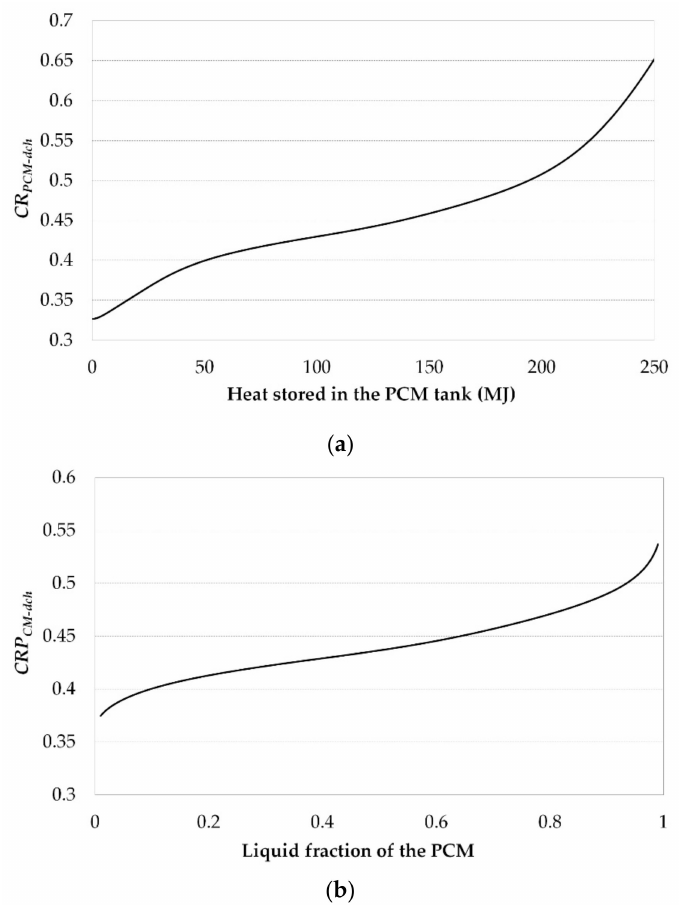
Figure 9. Value of CR in the PCM discharge mode against ( a ) heat stored in the tank and ( b ) liquid fraction of the